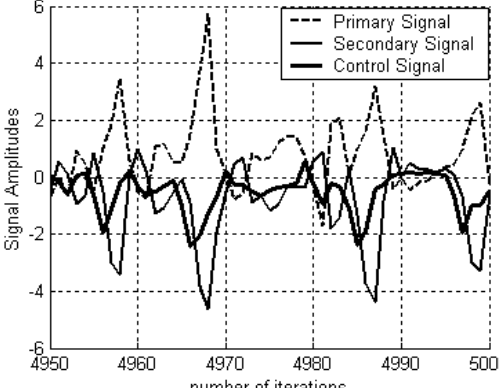
Fig. 8. Time histories of the signals in the last 50 iterations. The dashed line shows the primary signal, the thin line shows the secondary signal, and the thick line shows the control